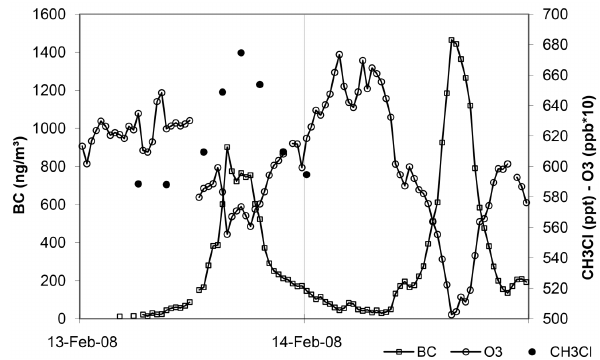
Fig. 9. Behaviour of CH 3 Cl, BC and ozone at NCO-P during a fire episode along the Khumbu